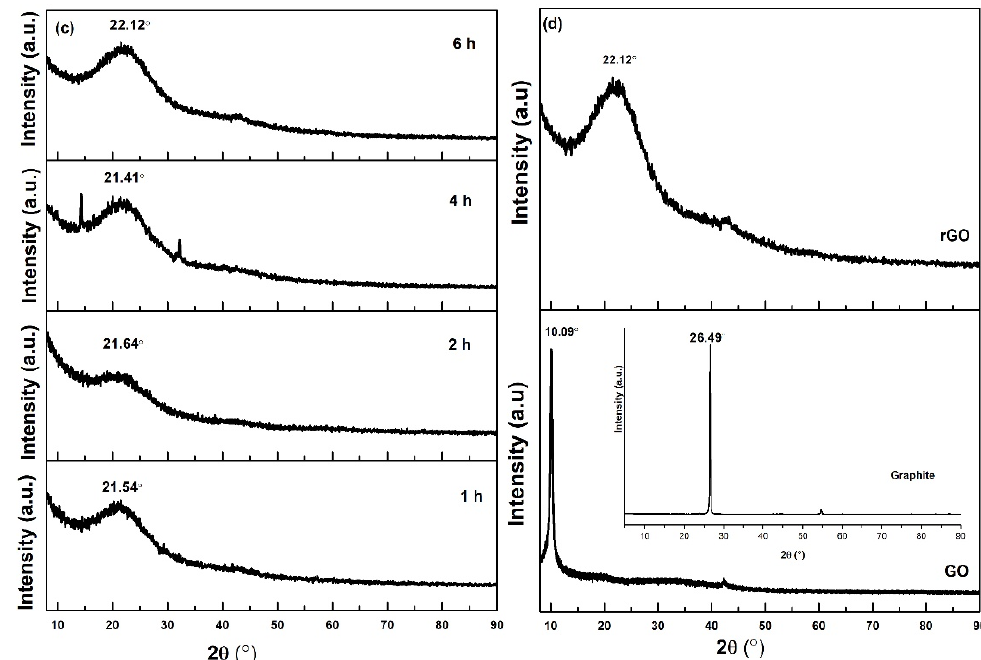
Figure 5. X-ray diffraction patterns of GO reduction at various ( a ) temperatures, ( b ) concentration of C. nutans leaf extract, ( c ) time, and ( d ) GO and rGO (insert figure is result of graphite). Table 2. The distance between carbon plane and XRD peak was determined using Bragg’s Law equation. Sample 2